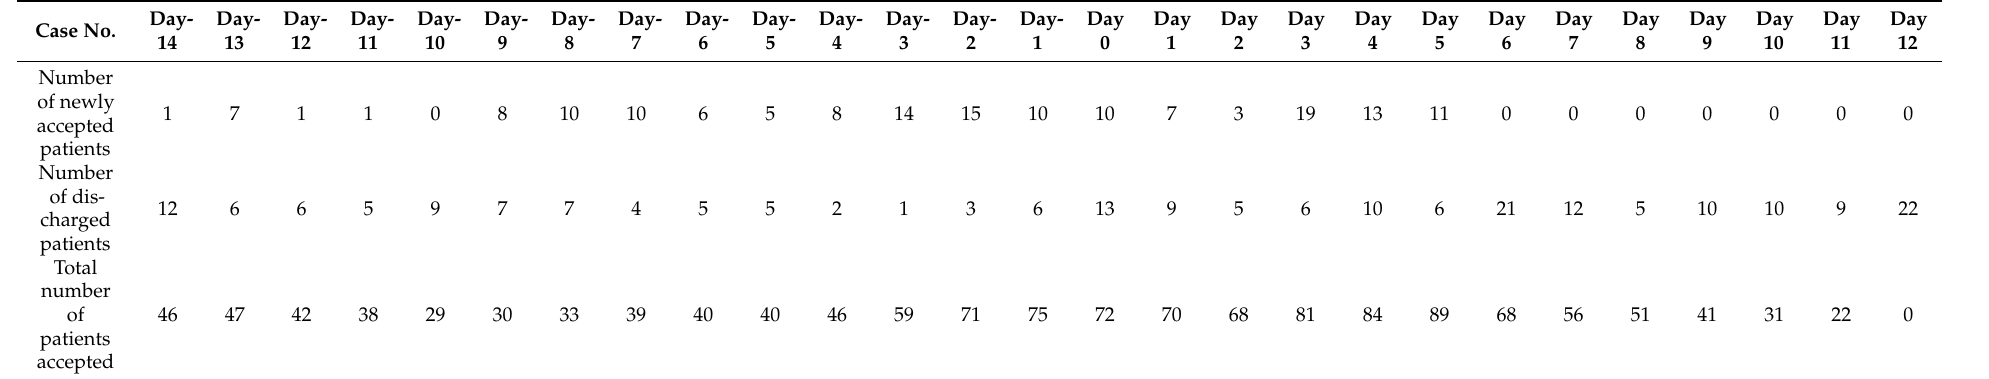
Table 1. Transition of the number of patients accepted at the accommodation facility during the cluster